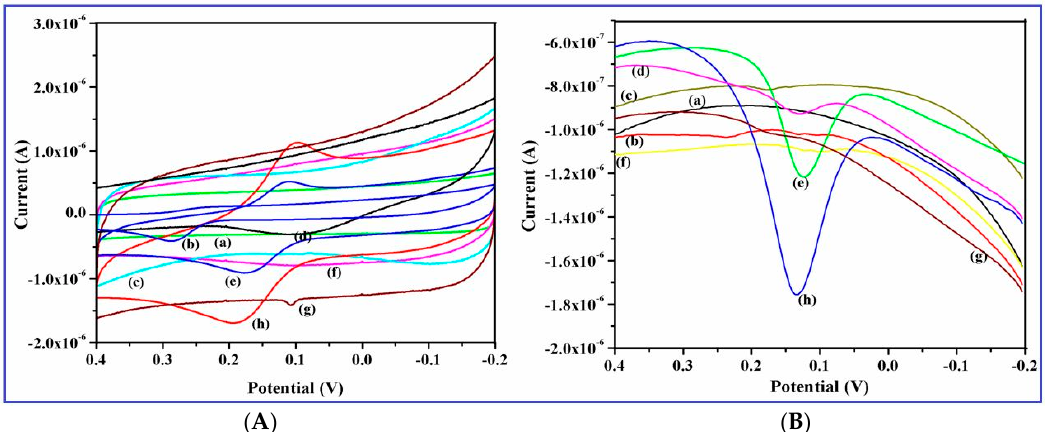
Figure 11. Interference studies on CuO nanowires/GCE recorded in 0.1 M phosphate buffer (pH 7.4) in the absence and presence of (a) blank (b) 100 µM UA (c) 100 µM CA (d) 100 µM AA (e) 100 µM DA (f) 100 µM Nacl (g) 100 µM glucose and (h) mixture of 100 µM of each species ( A ) cyclic voltammetry (CV) curves and ( B ) DPV curves, respectively.